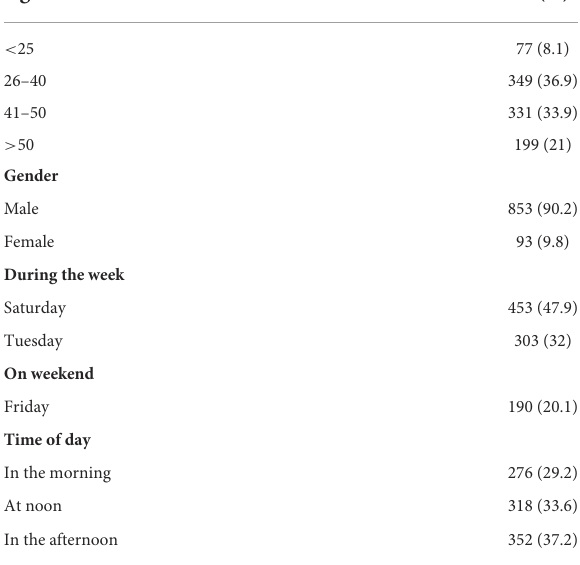
TABLE 1 Demographic characteristics of drivers at traffic lights in Shahin De, Iran (N = 946).